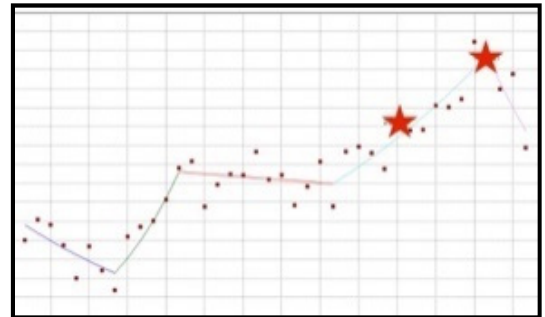
Figure 10. A schematic graph of the frequency of use of vitamin D in the respective quarters in the period from the first quarter of 2012 to the fourth quarter of 2021. The star denotes the moment of publication of the resolution concerning the ingredient. The height of placement of the symbol reflects the level of use of the ingredient. Vitamin D (Figure A37).